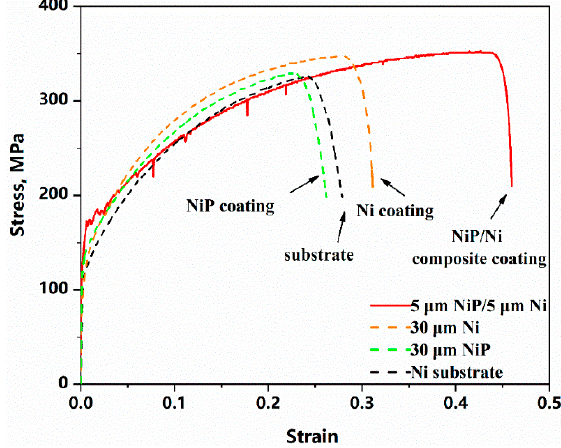
Figure 2. Engineering stress–strain curves of 4 kinds of the specimens. The red solid curve corresponds to the CG Ni substrate with 5 µ m NiP/Ni composite coating. The black dotted curve corresponds to the substrate. The green dotted curve corresponds to the substrate with polycrystalline Ni coating. The orange dotted curve corresponds to the substrate with amorphous NiP coating.